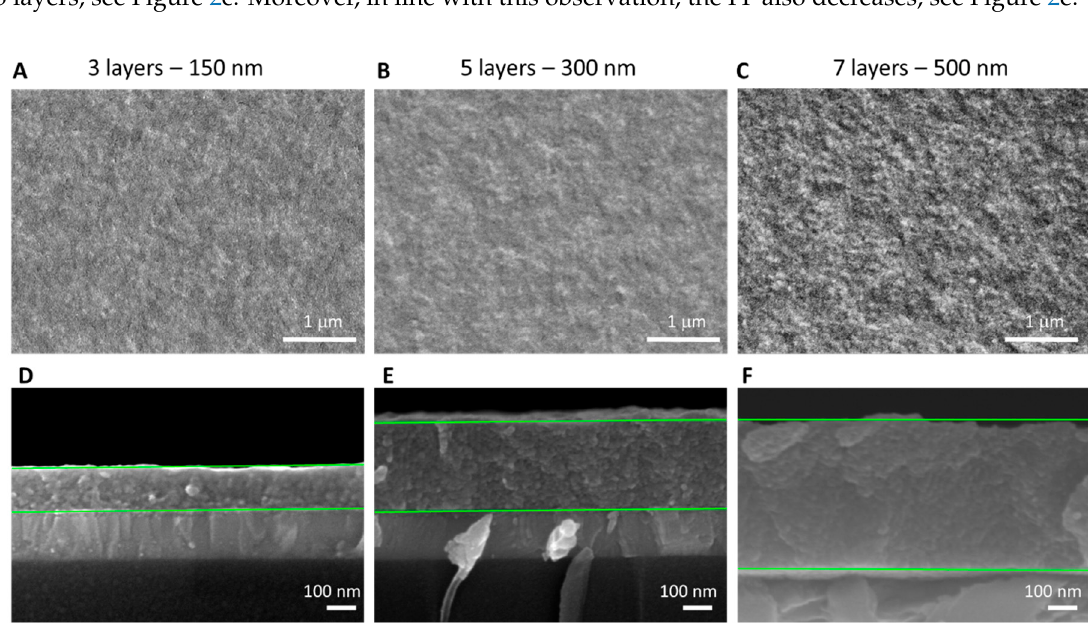
Figure 3. Top view SEM images of the CsPbI 3 QDs films deposited layer by layer. ( A ) 3 layers, ( B ) 5 layers, ( C ) 7 layers. Cross section SEM images of the staked CsPbI 3 QDs layers deposited over the SnO 2 electron transporting layer (ETL). ( D ) 3 layers, ( E ) 5 layers, and ( F ) 7 layers.